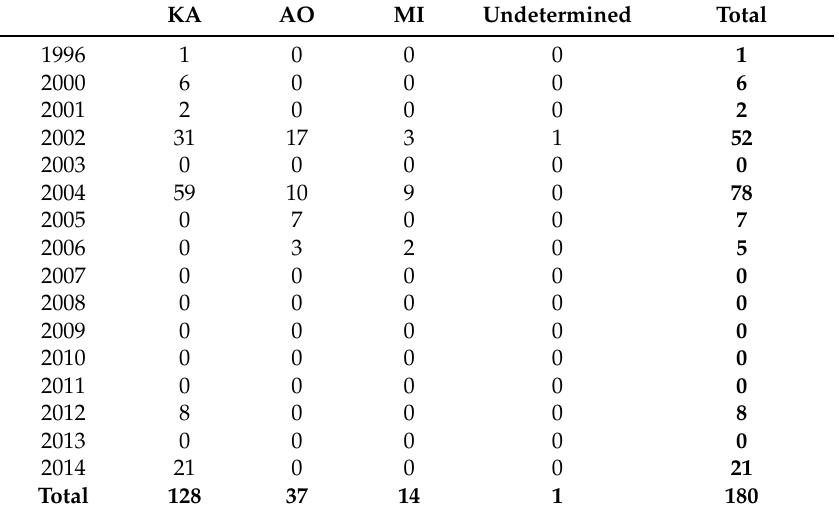
Table 2. Number of isolates for the C/Kanagawa lineage by antigenic group. KA AO MI Undetermined